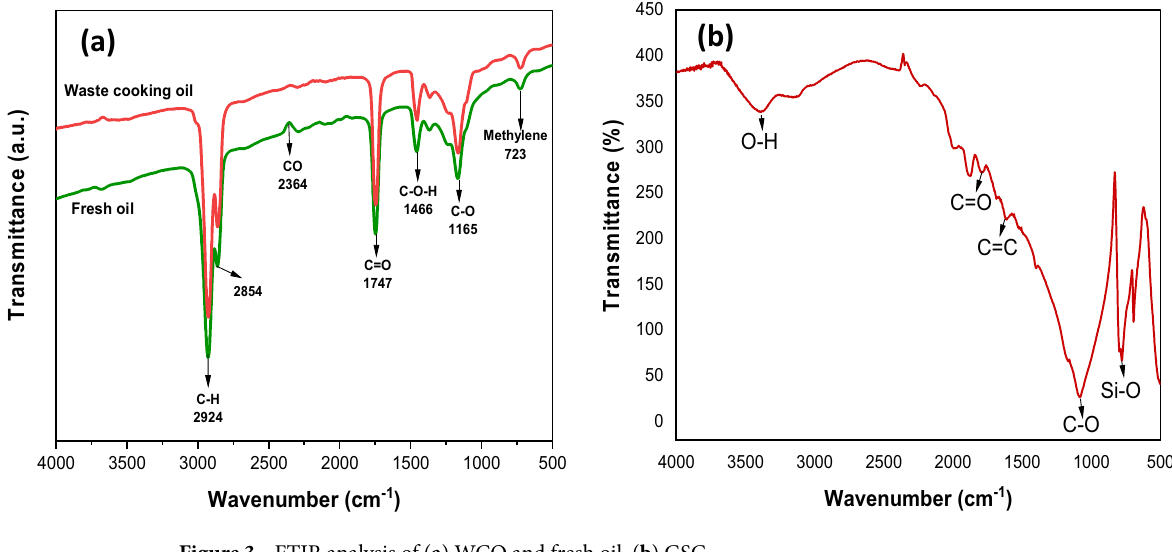
Figure 3. FTIR analysis of ( a ) WCO and fresh oil, ( b ) GSC WCO